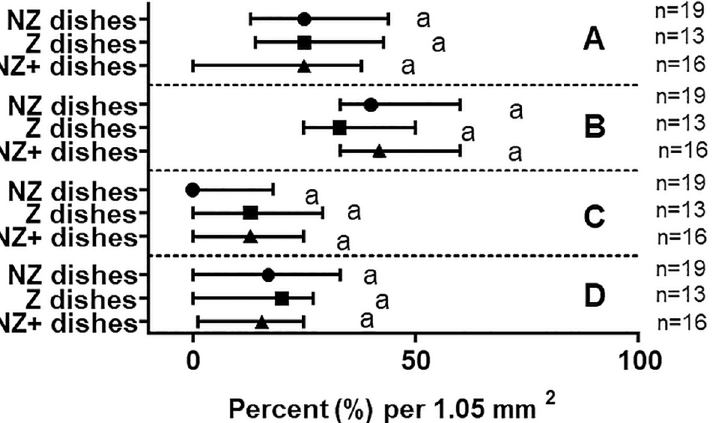
Fig 4. Shape classification and occurrence of 3-D endometrial cell structures. Occurrence as a percentage per micrograph area of circular (A), elliptical (B), elongated (C), or irregular shapes (D) observed after two weeks of culture in different treatment groups (Median with IQR). Number of replicates for each treatment group are in parentheses. Matching lowercase letters indicate the absence of difference within each shape (P > 0.05).